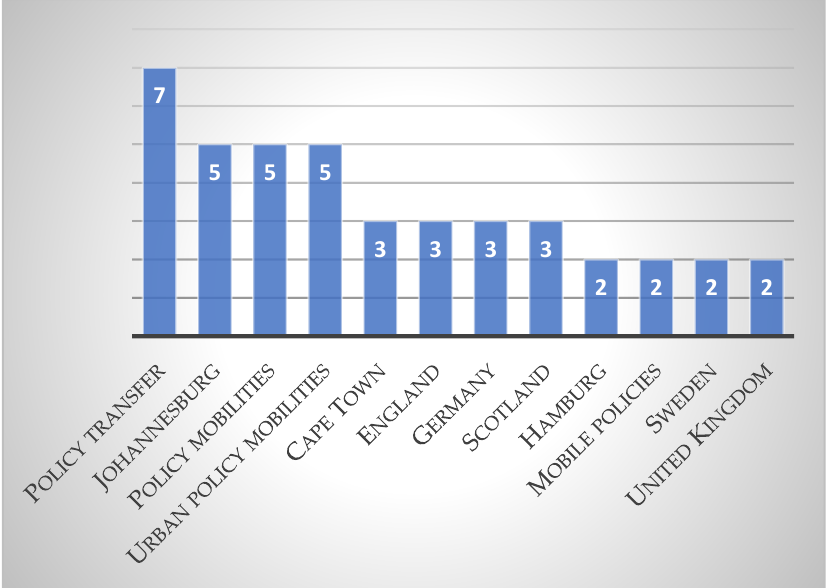
Figure 7. List of keywords from the research subject “Urban policies: mobility and transfer”. Source: author (2021), after initial screening and selection of publications. Note: in this figure, only keywords with two or more listings were included.